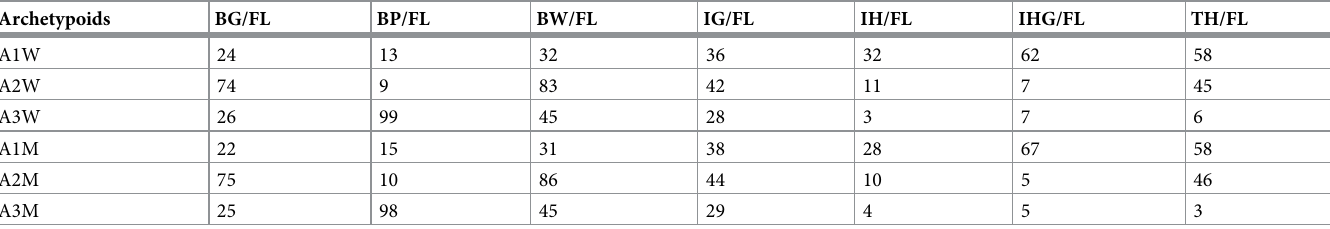
The first three archetypoids correspond to the sample of women. They are denoted by A1W, A2W and A3W. The last three archetypoids correspond to the sample of men. They are denoted by A1M, A2M and A3M. See details in the text about the meaning of the variables.